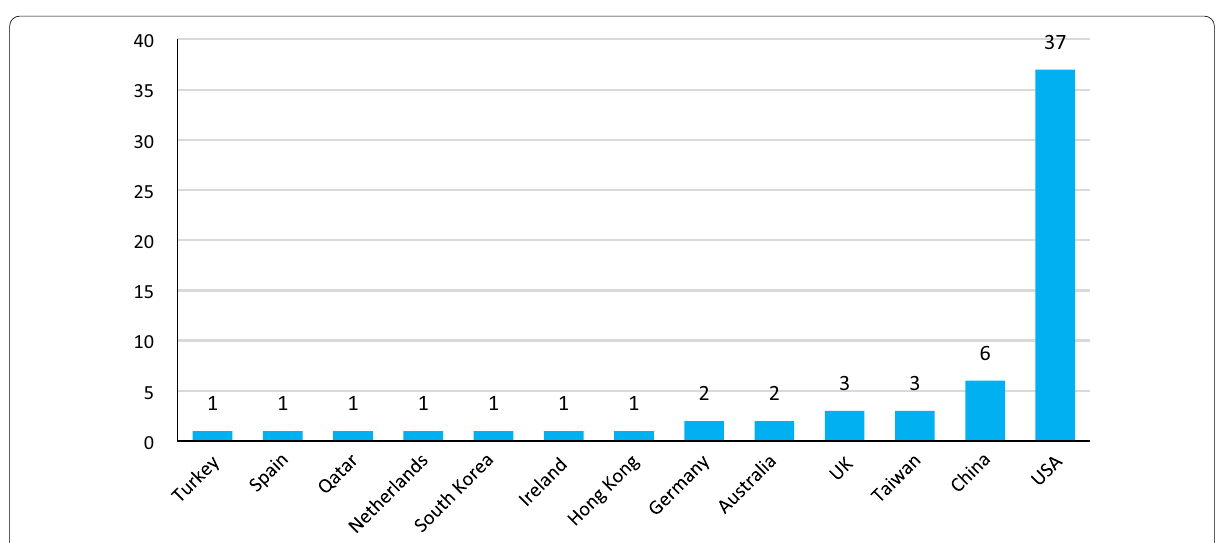
Fig. 7 Publication distribution by the corresponding author’s nationality/region